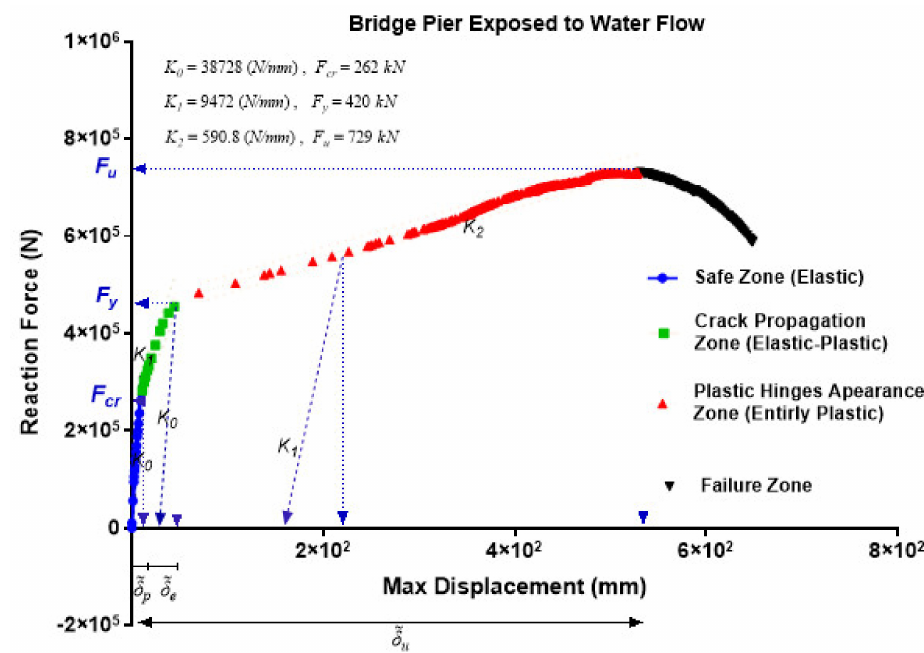
Figure 7. Load-deformation performance for a bridge pier under water-flow